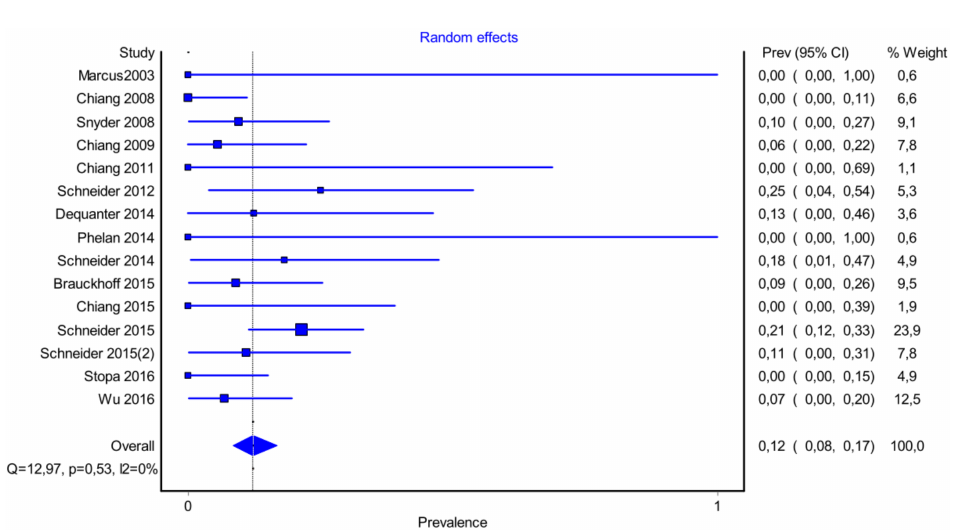
Figure 9. Forest plot P2 (subgroup analysis).